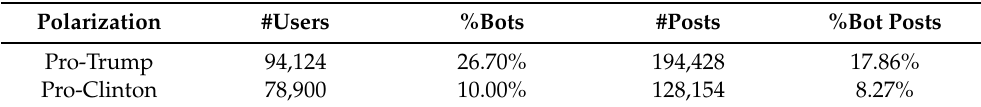
Table 2. Supporting posts and users per